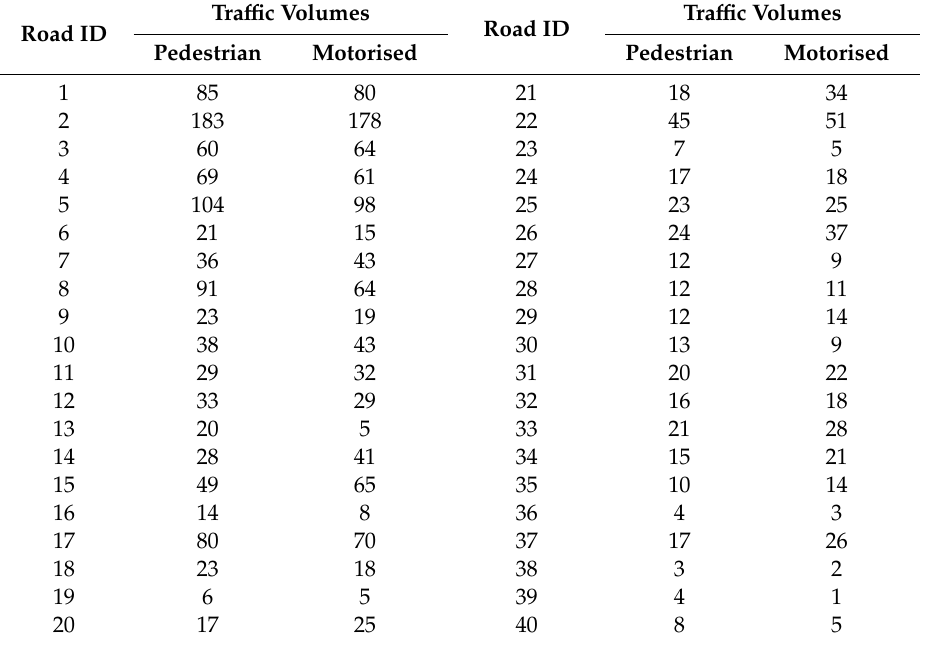
Table 2. Results of the tra ffi c observations campaign, with a sample rate of 10